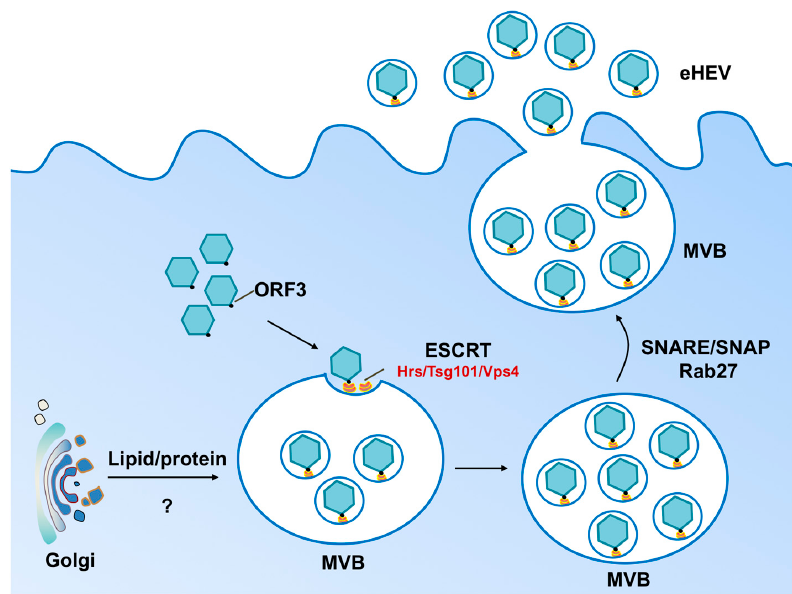
Figure 1. Model for biogenesis of eHEV. During the late stage of infection, HEV capsids are assembled in the cytoplasm and encapsidate viral genomes. ORF3 interacts with both Tsg101 (an ESCRT-associated protein) and the viral capsid, directing the budding of the viral capsid into the multivesicular bodies (MVB). Other components of the ESCRT machinery, including Hrs and Vps4, are also implicated in eHEV release. The quasi-enveloped HEV particles are subsequently released from infected cells upon fusion of the MVB membrane and the plasma membrane, a process that is regulated by Rab27 and other host factors such as SNARE/SNAP [31]. The origin of the eHEV membrane remains unclear, but is likely to derive from internal organelles such as the Trans-Golgi network.